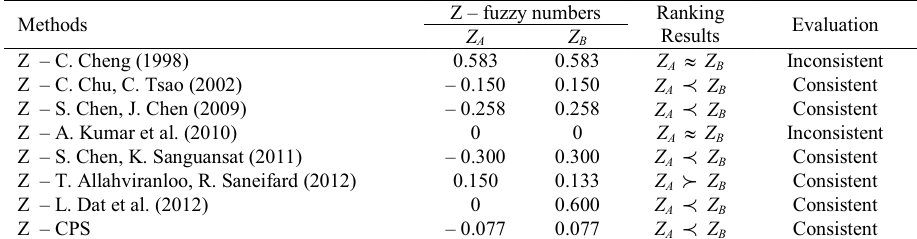
Table 4.Comparative results using Z – fuzzy numbers of Case